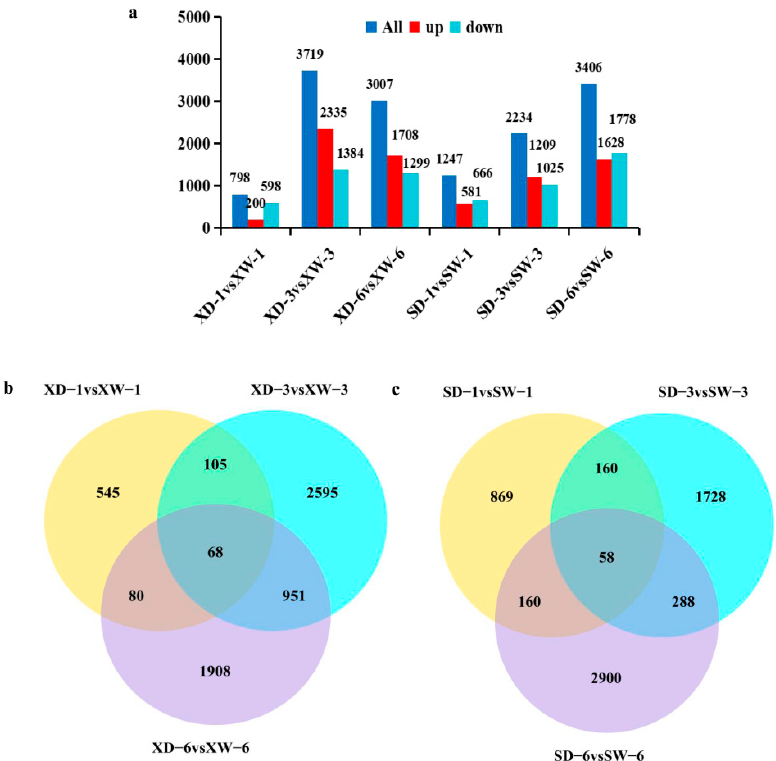
Figure 3. MC-induced DEGs in both cultivars at the three time points. ( a ) The number of DEGs up- or downregulated at 1, 3 and 6 d after MC treatment. X axis represents different comparisons and Y axis represents the number of DEGs identified. ( b , c ) Venn diagrams showing the number of DEGs unique to each time point or overlapping between different time points in XLZ74 ( b ) and SD1068 ( c ). XD and XW, XLZ74 treated with MC and water, respectively. SD and SW, SD1068 treated with MC and water, respectively.